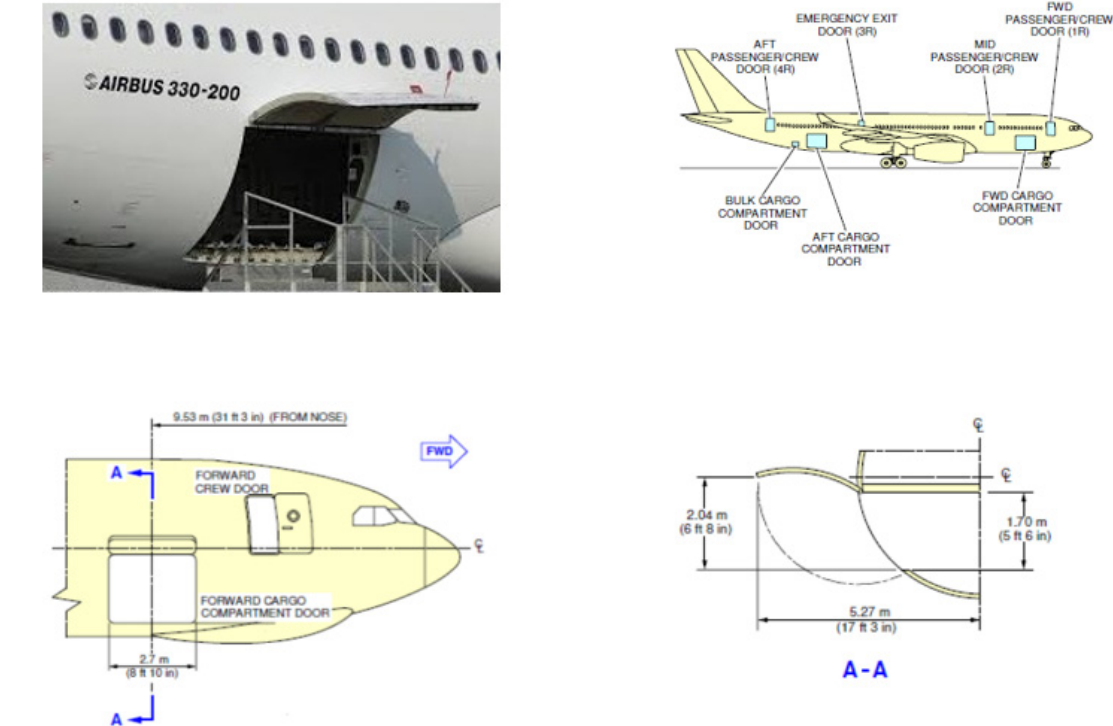
Figure 3. Airbus A330–200 cargo door position and dimensions [50].